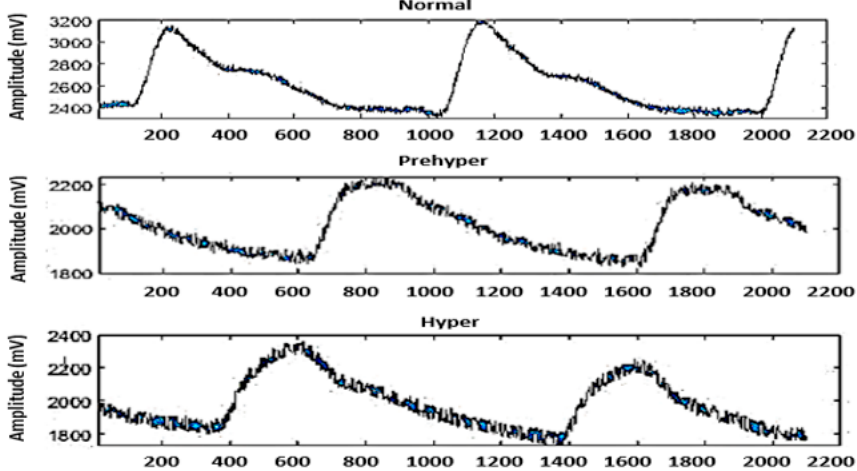
Figure 4. Three different BP classifications. Each segment consists of 2100 sampling points, corresponding to 2.1 s of data.